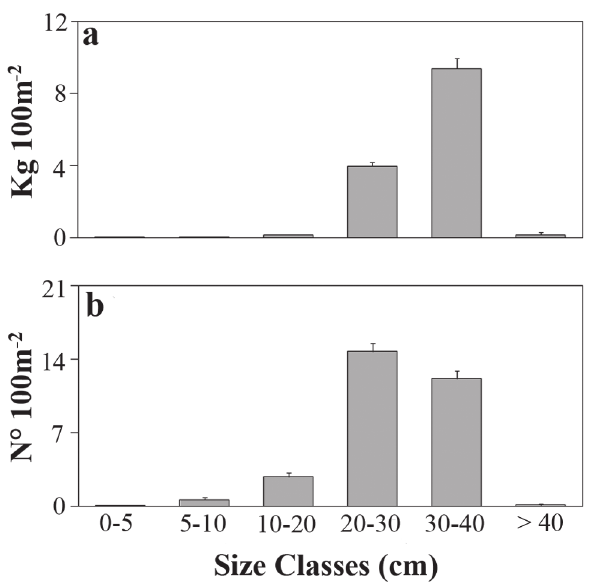
Fig. 3. Biomass ( a ) and Abundance ( b ) of different size classes of C. fulva at Trindade Island, Brazil. The error bars indicate standard error (SE).